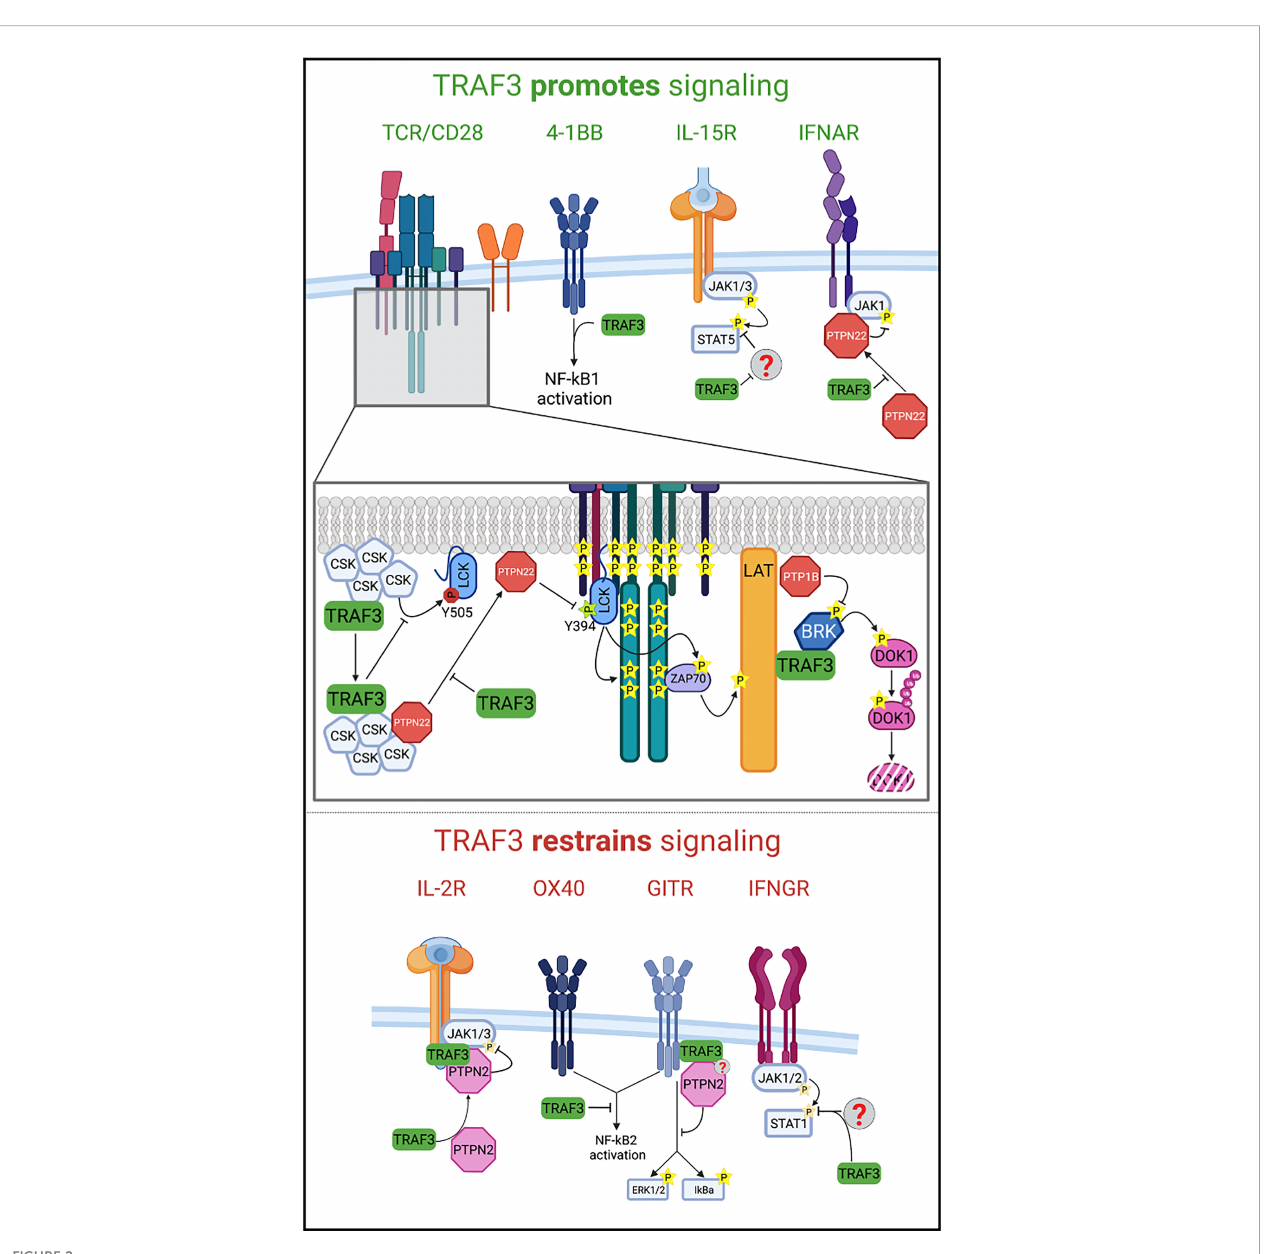
FIGURE 2 Mechanisms of TRAF3 regulation of T cell receptor signaling. Top: TRAF3 promotes signaling through the TCR/CD28, 4-1BB, IL-15R, and IFNAR by restraining negative regulators of signaling. Bottom: TRAF3 restrains signaling through the IL-2R in thymic Treg precursors and conventional CD4 + T cells, OX40, GITR, and IFNGR by mechanisms dependent on the phosphatase PTPN2 or